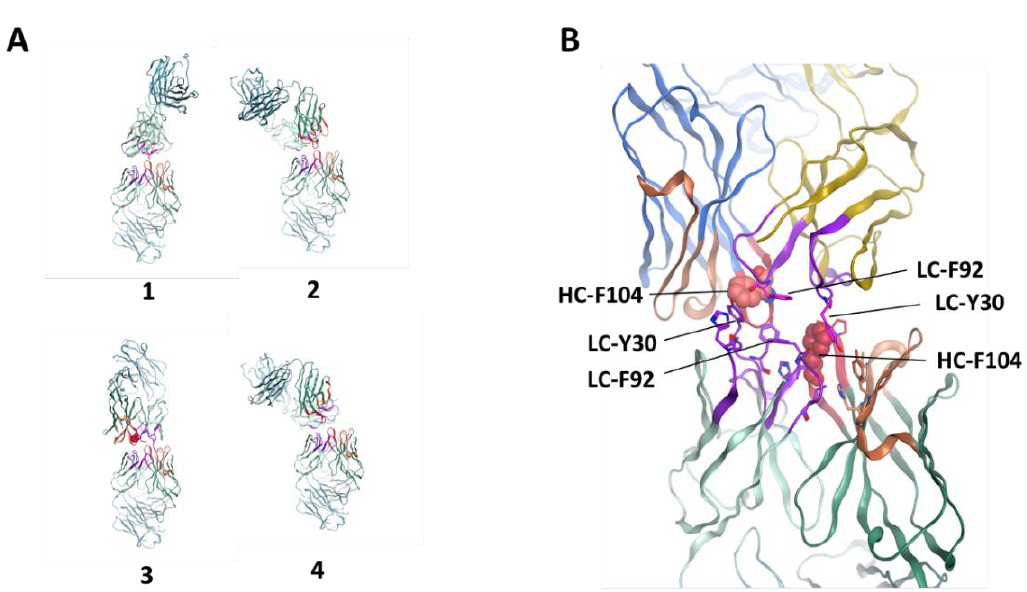
Figure 6. Fab protein-protein docking results. ( A ) Four poses seen in the top epitope cluster. ( B ) Details of model #3, a model for self-interaction supported by experimental data.